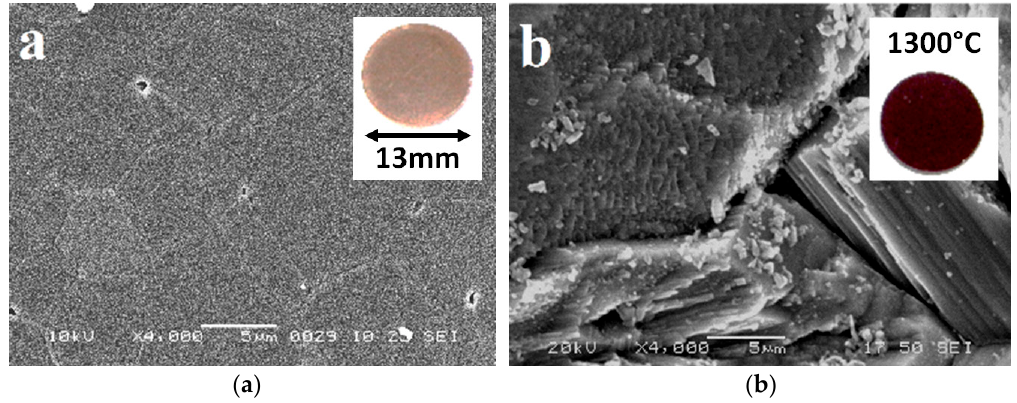
Figure 3. SEM images at same scale of ( a ) non-reduced TiO 2 ; ( b ) TiO 2 carbo-thermally reduced at 1300 °C. Inset shows colour change of material.